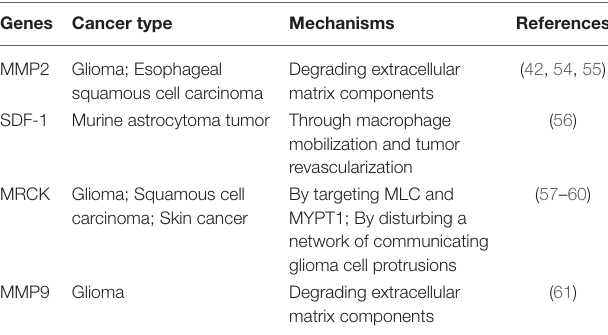
TABLE 2 | A summary of genes involved in irradiation-induced invasion of various cancers. Genes Cancer